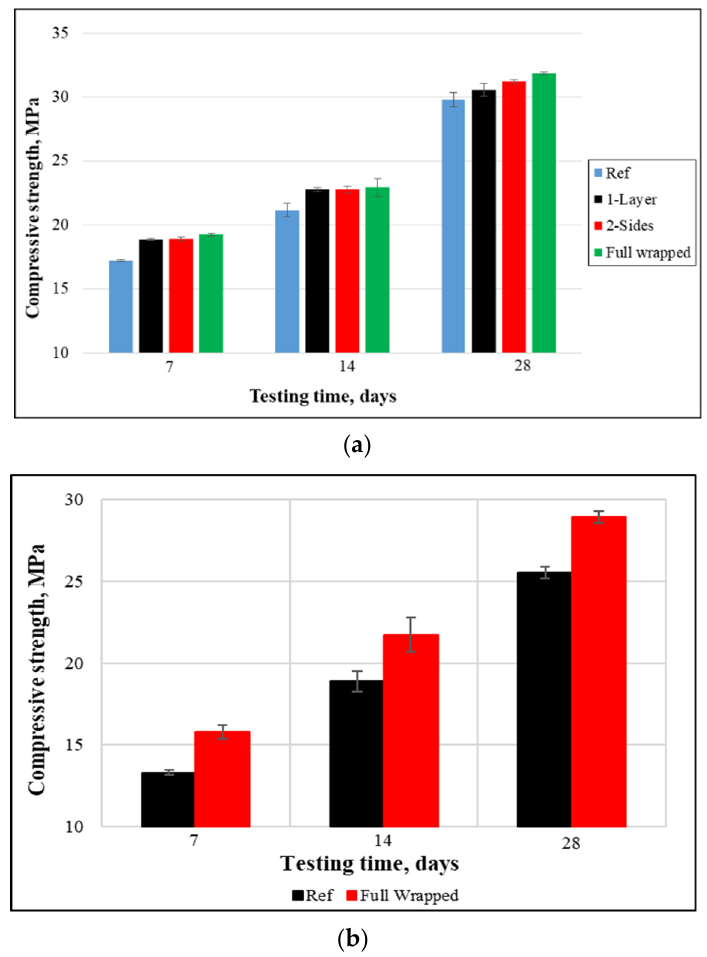
Figure 4. Compressive strength: ( a ) cubes and ( b ) cylinders.